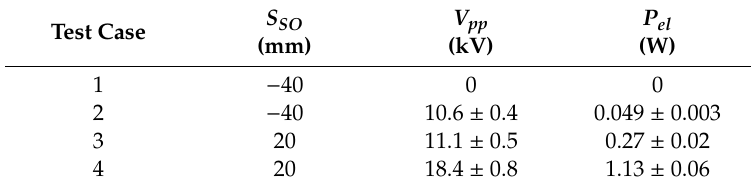
Table 1. Test matrix of experiments and operating conditions. Plasma actuation frequency of 20 kHz.